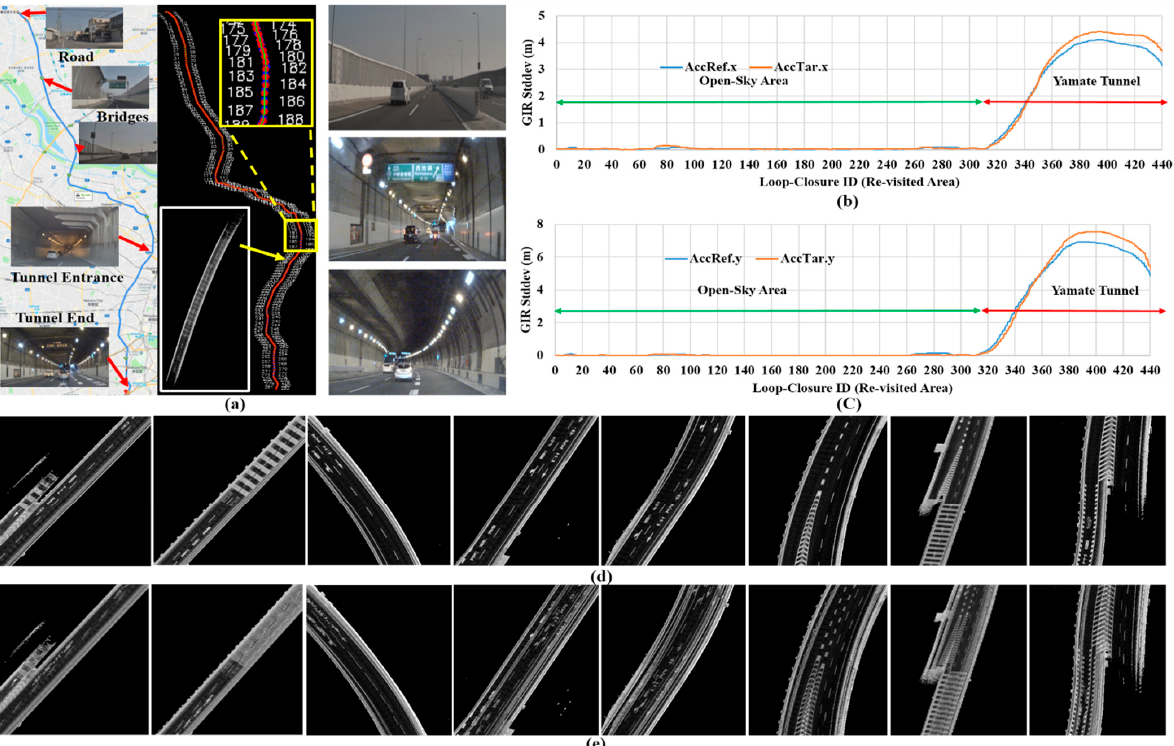
Figure 9. Scanning the world’s longest tunnel two times by the same agent. ( a ) Nodes along the course with showing identical distribution in two scans. ( b , c ) GIR accuracy profile in XY directions indicating high accuracy in the open-sky area because of receiving good quality satellite signals and low accuracy all the way inside the tunnel. ( d ) Road surface images in the first scan. ( e ) GIR-combined map images showing the massive deviation between two